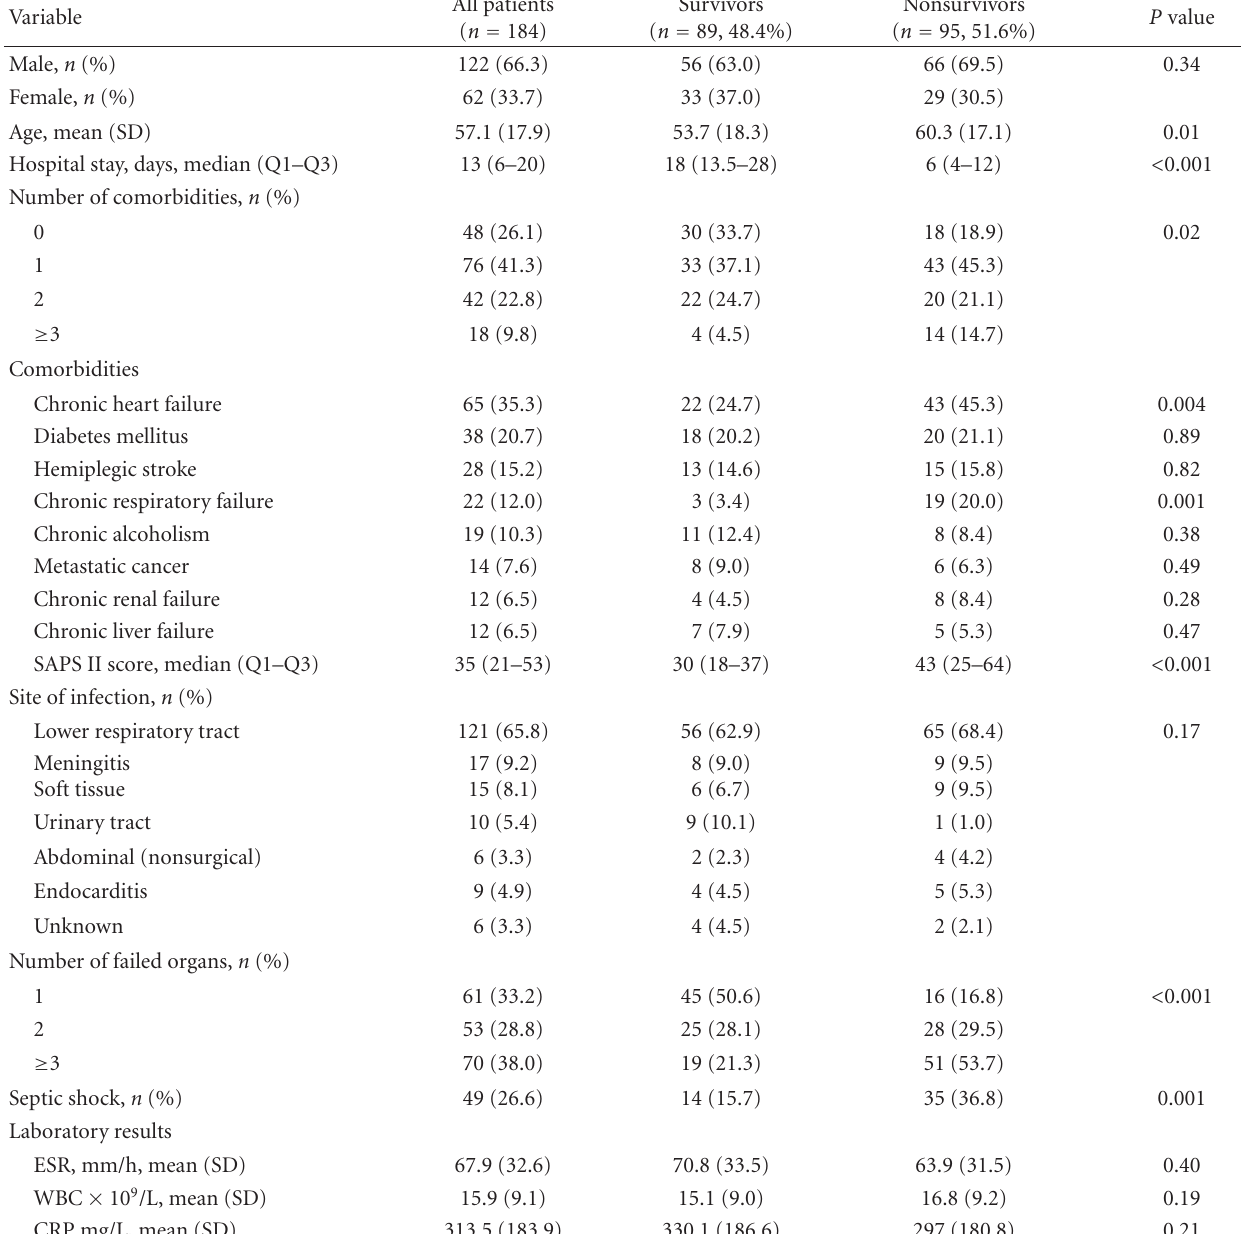
Table 1: Demographic and clinical characteristics of patients with severe sepsis according to outcome.